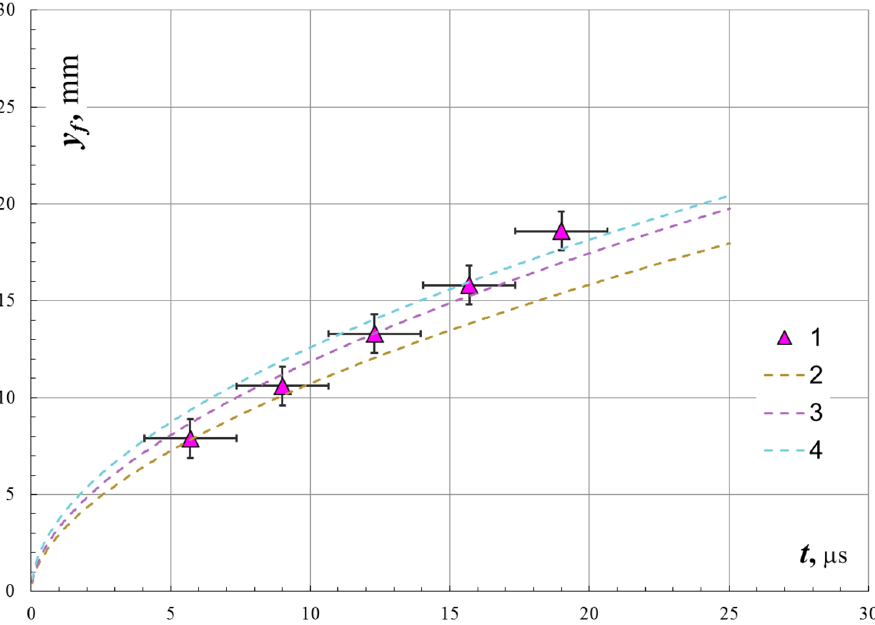
Figure 7. Dependence of the vertical coordinate of the shock wave front on time y f after the energy input: symbols (1)—experiment; lines (2–4)—simulations: (2) 500 ns duration, 0.22 J energy, 60 mm 3 volume; (3) 600 ns, 0.29 J, 90 mm 3 ; (4) 800 ns, 0.29 J, 60 mm 3 . Flow Mach number is 1.40. The zero-time corresponds to the beginning of energy input.